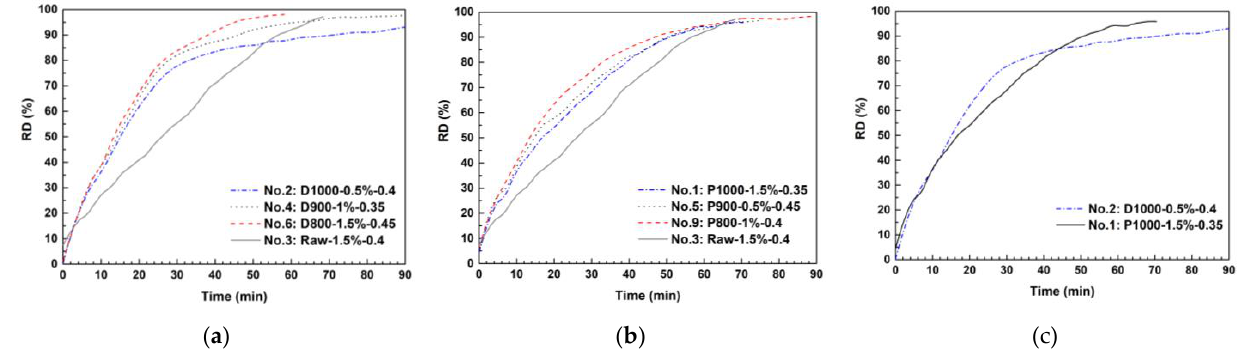
Figure 3. The reduction curves of the samples with different oxidation treatments: ( a ) deeply oxidized at different temperatures; ( b ) partly oxidized at different temperatures; ( c ) oxidized at 1000 °C.